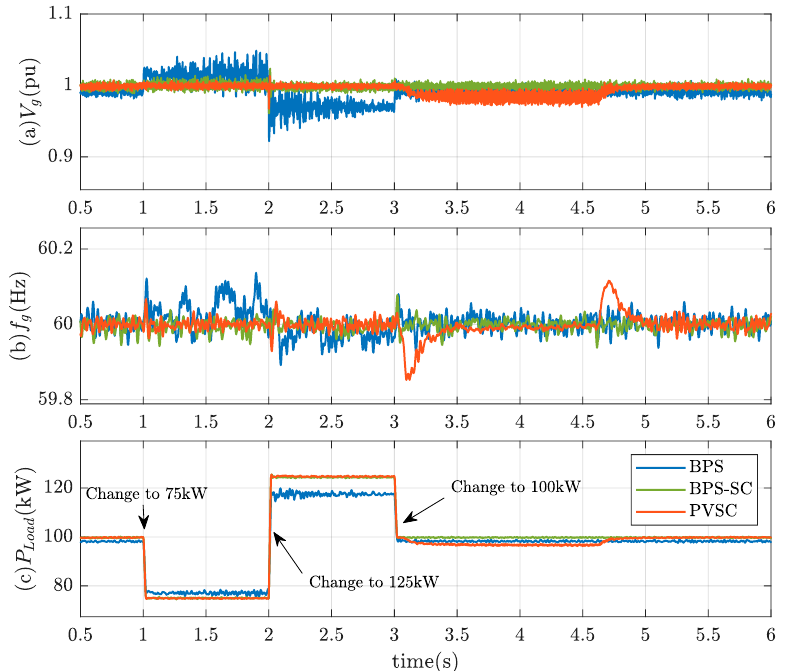
Figure 26. Step load change in local load: ( a ) and ( b ) grid voltage and frequency at load point and ( c ) load power.